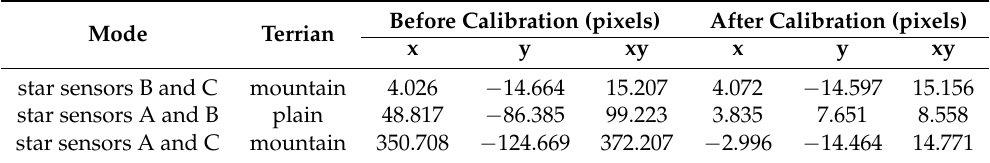
Table 9. The geometric accuracy improvement with different star sensor combined modes for on-orbit satellites. Before Calibration (pixels) After Calibration Mode Terrian